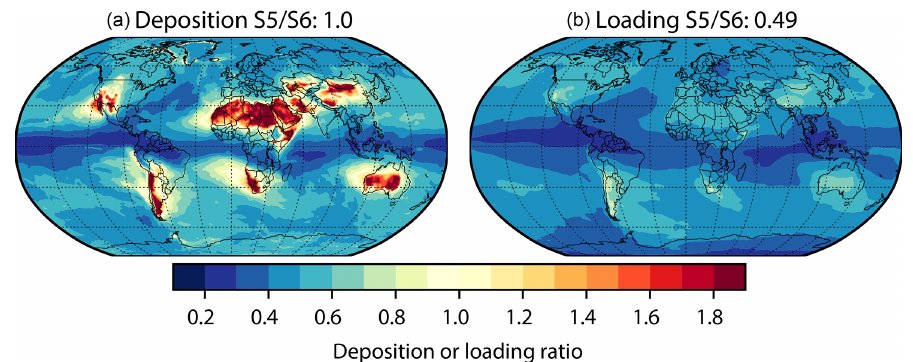
Figure 8. Impact of changing the coarse-mode geometric standard deviation ( σ ) for transported dust aerosol on the modeled dust surface deposition fluxes and column loading: ratio of NEW_EMIS_SIZE (S5: σ = 1.8) to NEW_EMIS (S6: σ = 1.2) (see Table 2 for case names). Numbers on the top of the plot show ratios on global